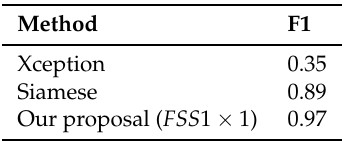
Table 7. Comparison between standard DL methods and our proposal.